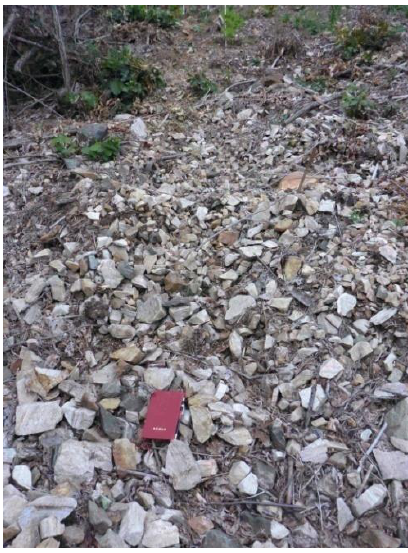
Figure 5. Small scale talus distribution on mountain slopes.